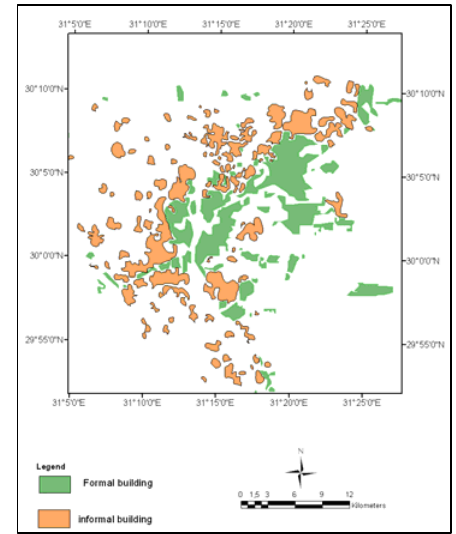
Figure 4. The distribution of formal (green) and informal urbanization (brown) in the study area